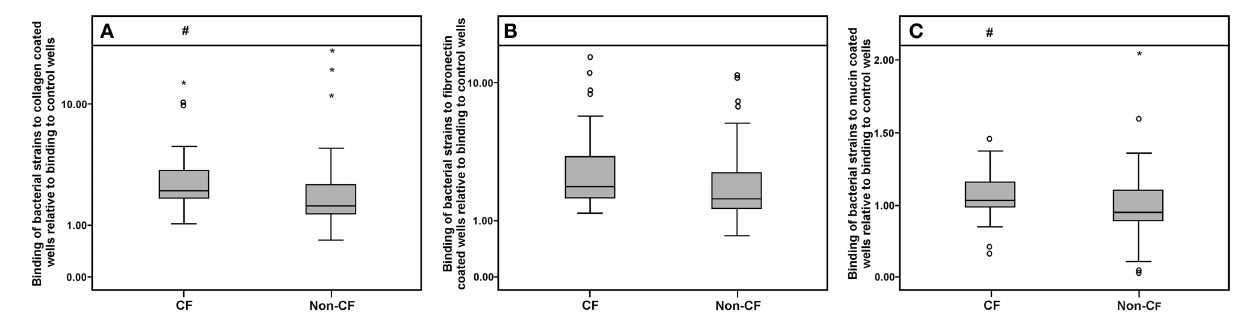
FIGURE 7 | Heat map demonstrating the distribution of virulence traits in CF- and non-CF Achromobacter isolates. Results were approximated on the relative scale ranging from 0 (blue) as the lowest values, progressing to white, then to 100 (red) as the highest values.